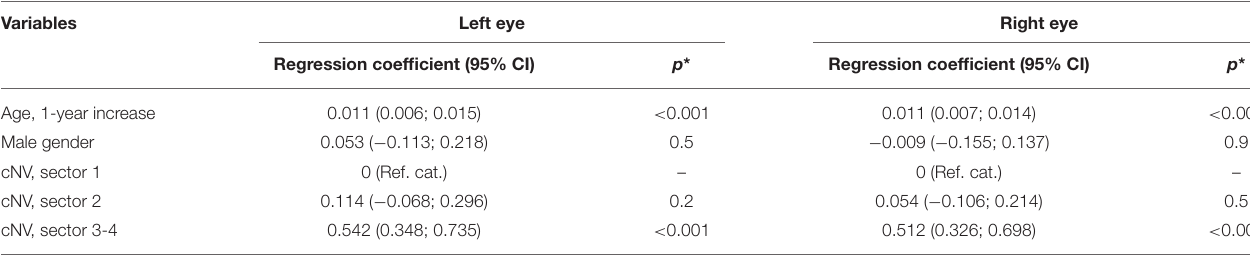
TABLE 2 | Multivariate analysis predicting visual acuity (logMAR).